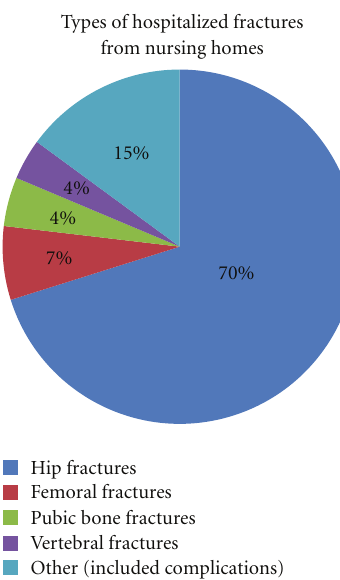
Figure 5: Types of fractures on admission from nursing home to hospital in Bergen, Norway, during the period from March 2006 to March 2007 ( N =